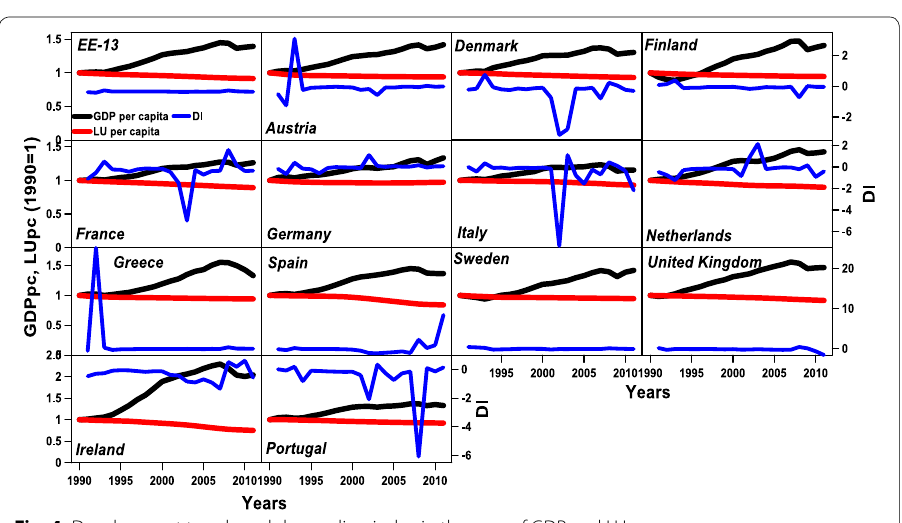
capita and the index of GDP per capita, while the right-hand side vertical axis represents for each case the decoupling indices in per capita